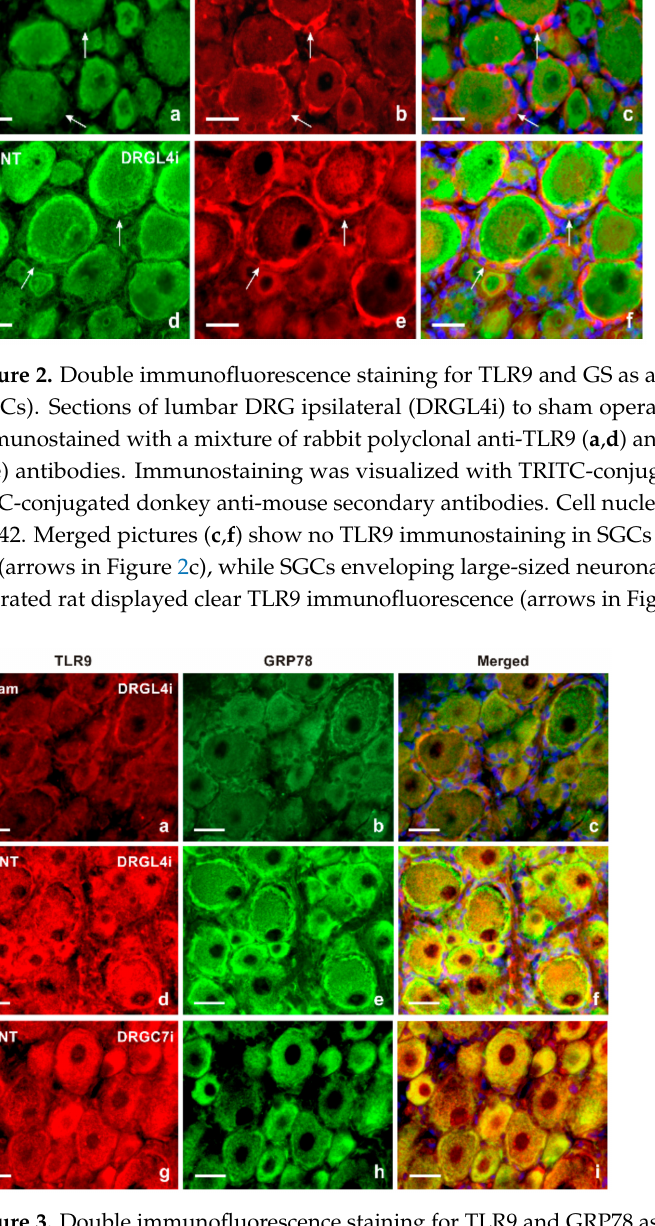
Figure 3. Double immunofluorescence staining for TLR9 and GRP78 as a marker of the endoplasmic reticulum (ER). Sections of lumbar DRG ipsilateral (DRGL4i) to sham operation (Sham) as well as DRGL4i and cervical DRG ipsilateral (DRGC7i) to CSNT were immunostained with mouse monoclonal anti-TLR9 ( a , d , g ) and rabbit polyclonal anti-GRP78 ( b , e , h ) antibodies and were visualized using donkey TRITC-conjugated anti-mouse and FITC-conjugated anti-rabbit secondary antibodies, respectively. Cell nuclei were stained with Hoechst 33342. Merged pictures ( c , f , i ) detected no or very weak TLR9 immunostaining in the ER of DRG neurons from the sham-operated animal ( c ), while most increased TLR9 immunofluorescence was co-localized with GRP89 in the ER of DRGL4i ( f ) and DRGC7i ( i ) from CSNT-operated rats. Scale bars = 20 µ